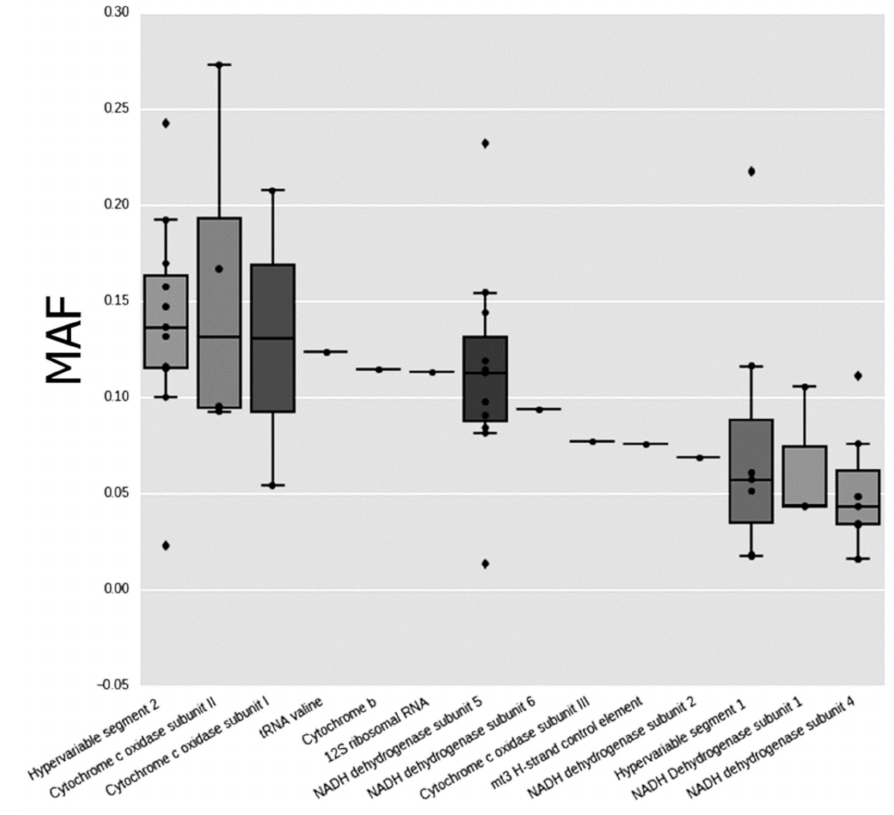
Figure 2. The boxplot showing minor allele frequencies (MAF) distribution of heteroplasmic variants in regions and genes of mtDNA. Circles, the cases falling into observed distribution; diamonds,